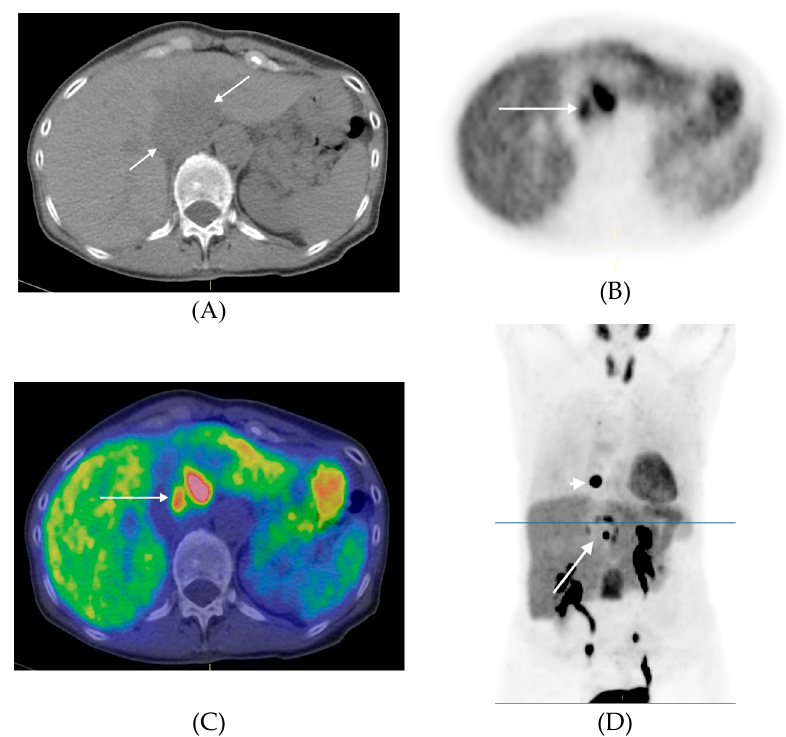
Figure 4. 11 C-HED-PET/CT of patient #24 (Table 4) with a retroperitoneal paraganglioma in front of the descending aorta with high heterogenous tracer uptake (long arrows) and a metastasis in the transverse process of the thoracic vertebra 10 shown in D (short arrow). In the coronal PET image an additional vertebral metastasis in the first lumbar vertebra is seen projected between the kidneys. ( A ) Transversal CT, ( B ) Transversal PET, ( C ) Transversal PET/CT fusion, ( D ) Coronal PET (Maximum Intensity Projection). The level of the transversal images are indicated in the coronal PET image (line).